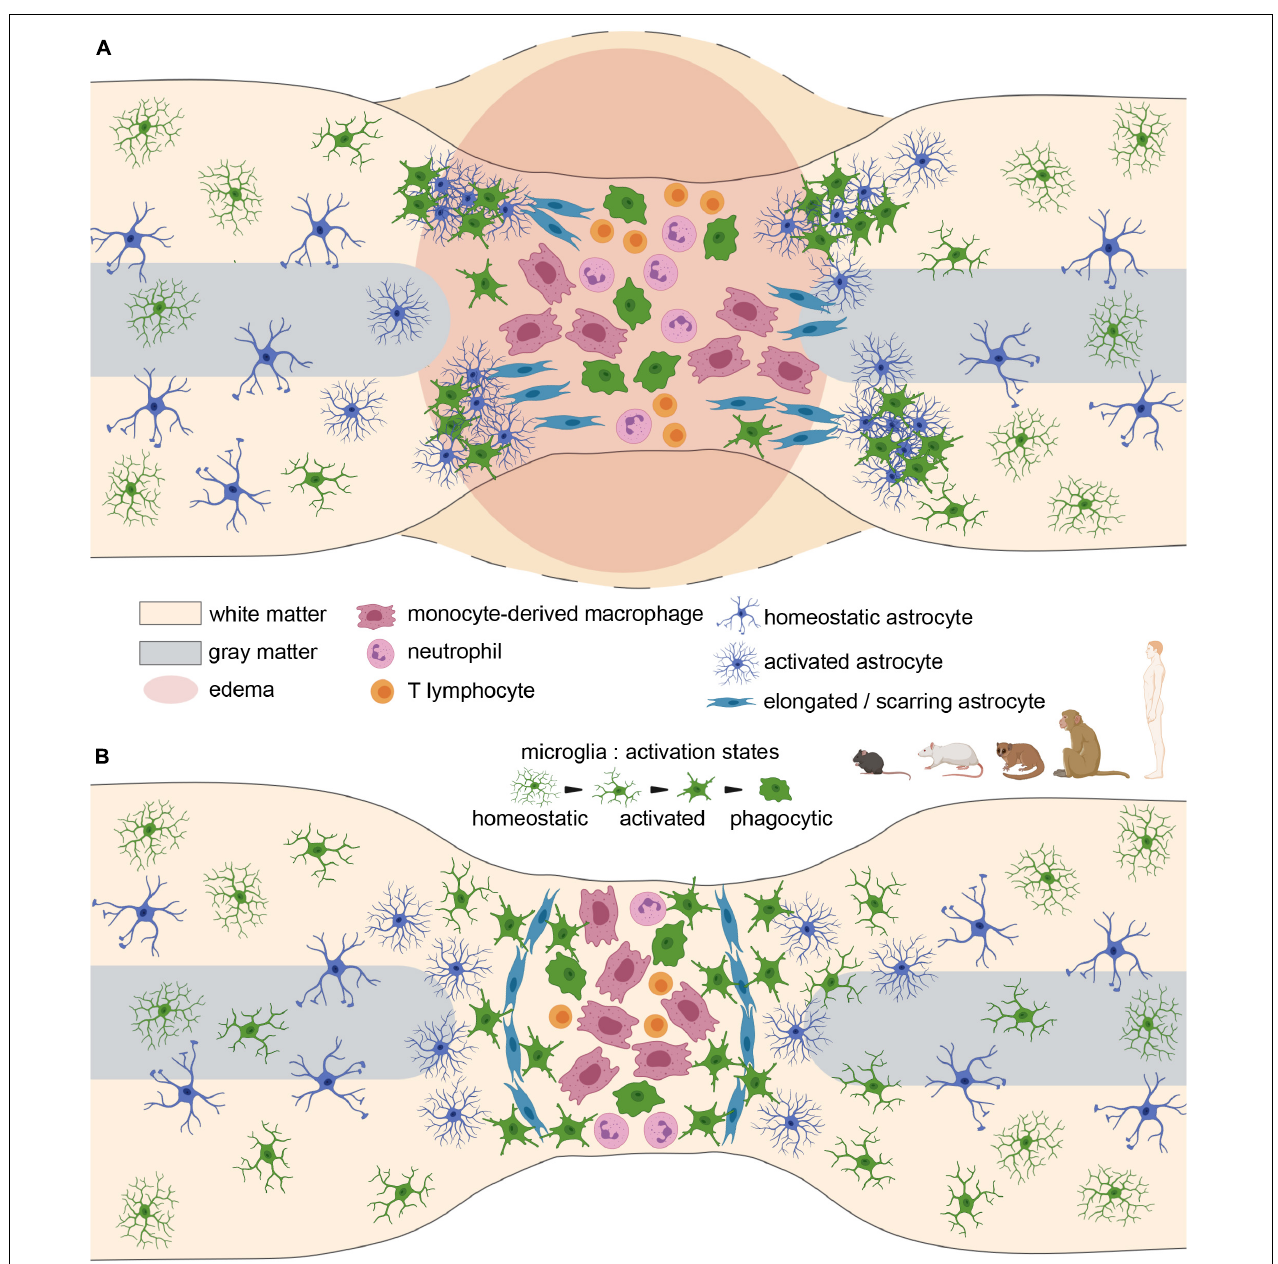
FIGURE 2 | Glial scar formation after spinal cord injury in rodents and primates. (A) Acute stage. Cellular infiltration, reactivity, proliferation, and edema at the lesion site. (B) Glial scar stabilisation at the subacute/chronic stage. Note the substantial role of scarring astrocytes in separating the lesion core from spared